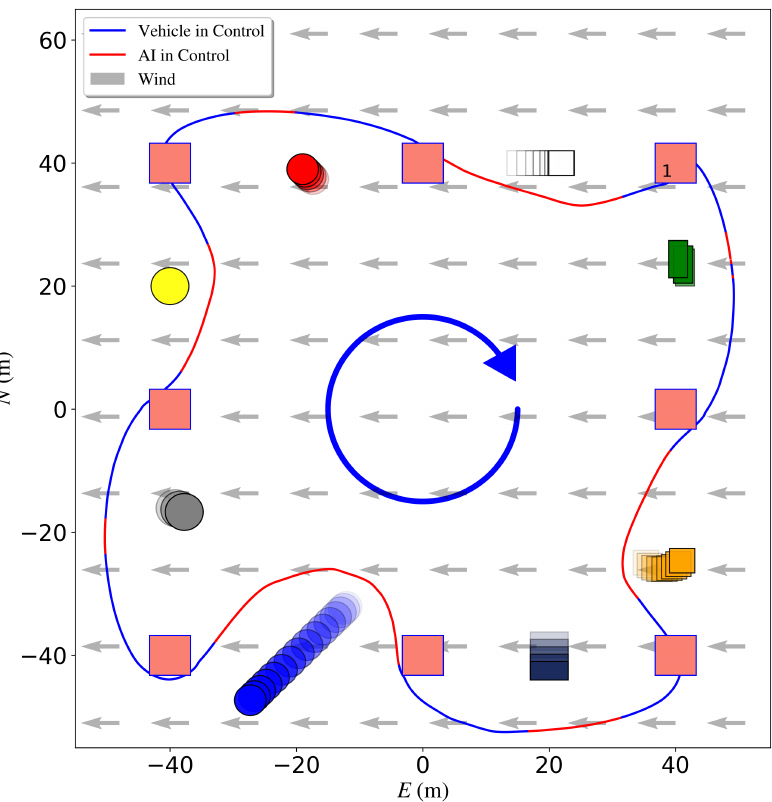
Figure 15. Simulated USV obstacle avoidance mission. Mission waypoints are shown as red squares, obstacles are shown in different colors, DRL agent augmented paths for avoidance in red, and the vehicle trajectory following the mission path in blue. The mission starts from waypoint